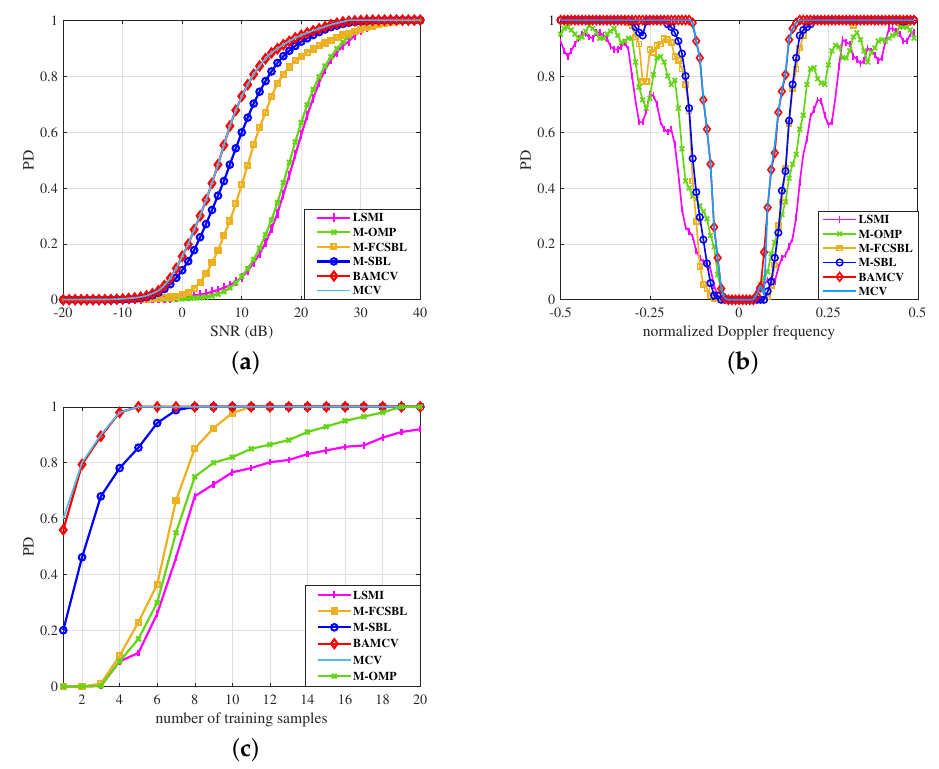
Figure 12. Average detection results of measured data. ( a ) PD versus SNR ( f d = 0.1, L = 10). ( b ) PD versus normalized Doppler frequency (SNR = 20 dB, L = 10). ( c ) PD versus the number of training samples ( f d = 0.1, SNR = 20 dB). f d denotes the normalized Doppler frequency of targets. L is the number of training